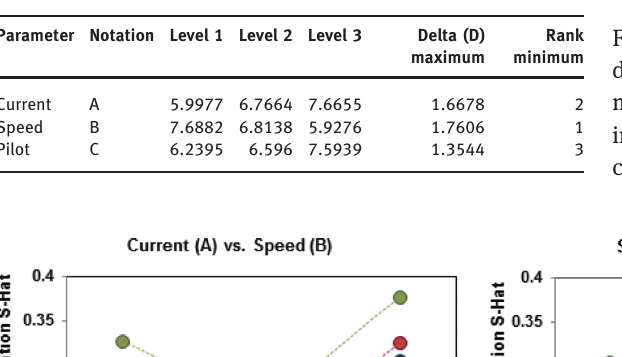
Table 5: S/N response table.